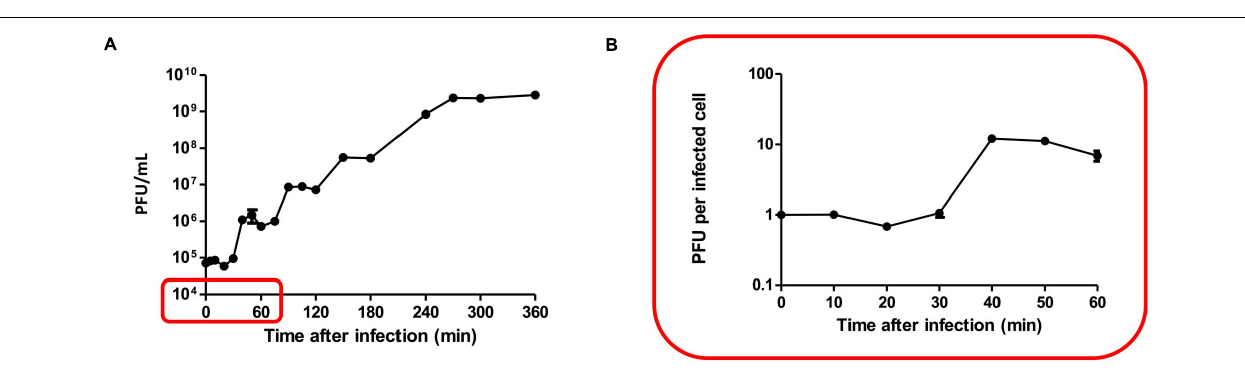
FIGURE 4 | One-step growth curve. The data shown are the mean values from four independent measurements, and the error bars represent the standard deviations. (A) Multiple bursts of roughly the same size occurred approximately 30 min after each burst until the phage concentration reached its